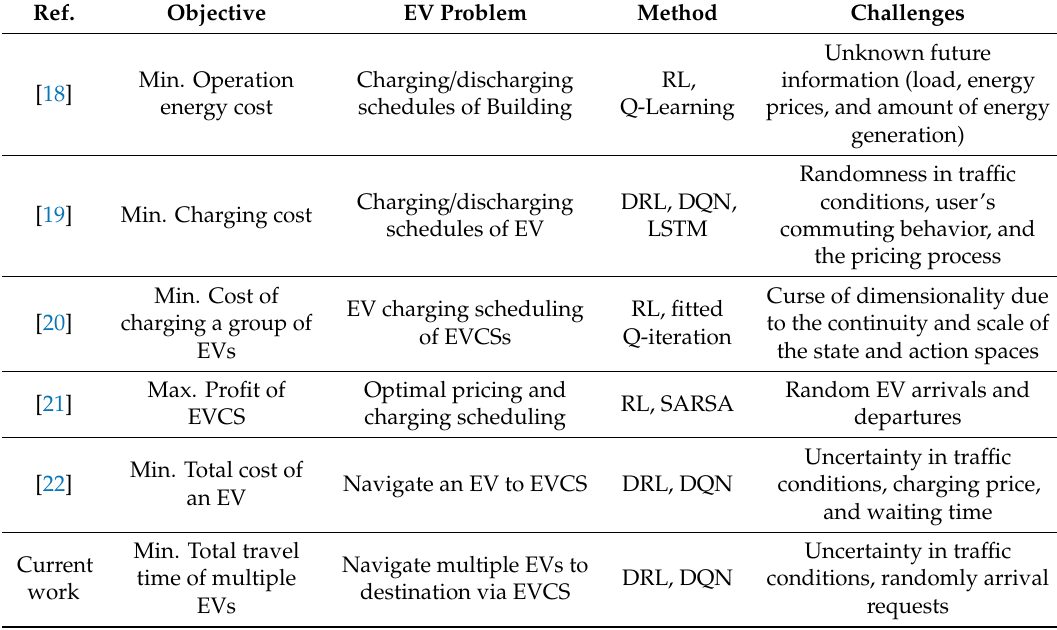
Table 2. Summary of literature review of main objectives and challenges of reinforcement learning for di ff erent electric vehicle applications.